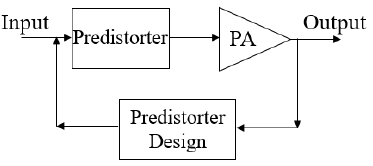
Figure 1. Block diagram of a DPD representation followed by a